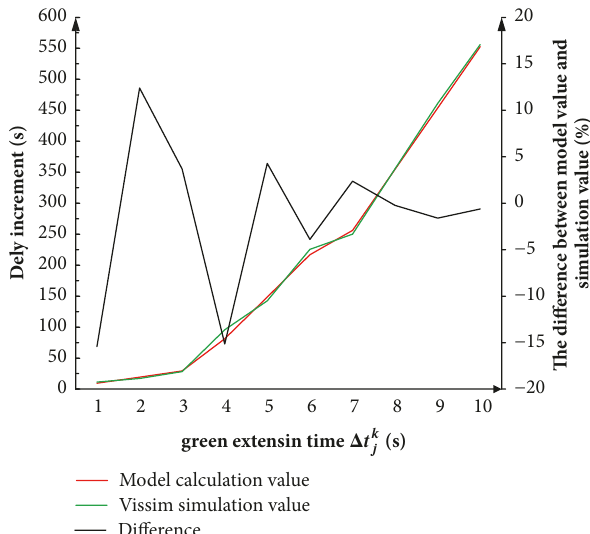
Figure 6: Comparison between the model calculation value and the simulation